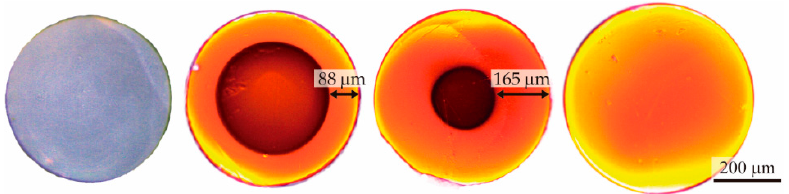
Figure 2. Microscope images of the cross-sections of POF samples immersed in a solution of rhodamine B and methanol at 10 °C for different time intervals, namely (from left to right): 0 h, 30 h, 54 h and 96 h. The image of the pristine fiber was taken in transmitting mode. The images of the doped fibers were obtained under lateral UV excitation.